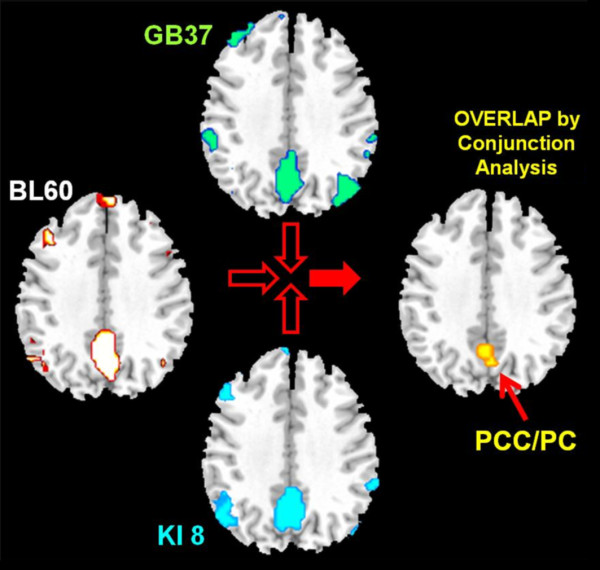
Results of conjunction analysis based on the DCT results. The masks of group-level DCT results of all three groups, i.e. GB37, BL60 and KI 8, were used to generate this map. The only overlapped region located in the posterior cingulate cortex and precuneus (PCC/pC) (p < 0.001, corrected, cluster size > 20 voxels, see the Methods for details).